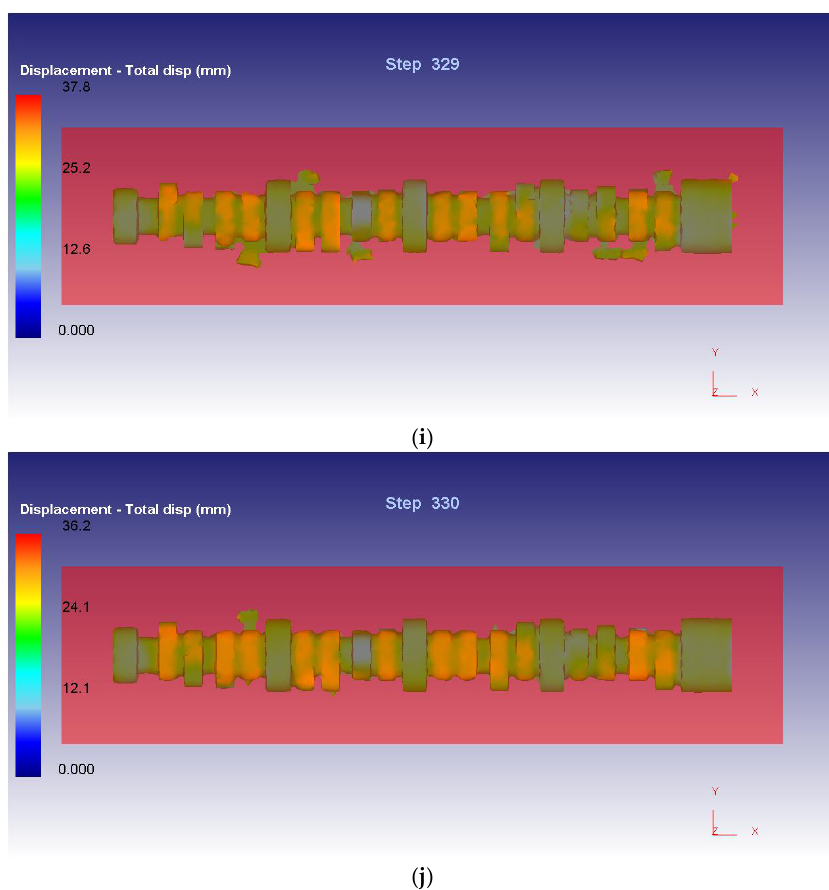
Figure 8. Flash produced in each case. ( a ) Case I; ( b ) Case II; ( c ) Case III; ( d ) Case IV; ( e ) Case V; ( f ) Case VI; ( g ) Case VII; ( h ) Case VIII; ( i ) Case IX; ( j ) Case X.